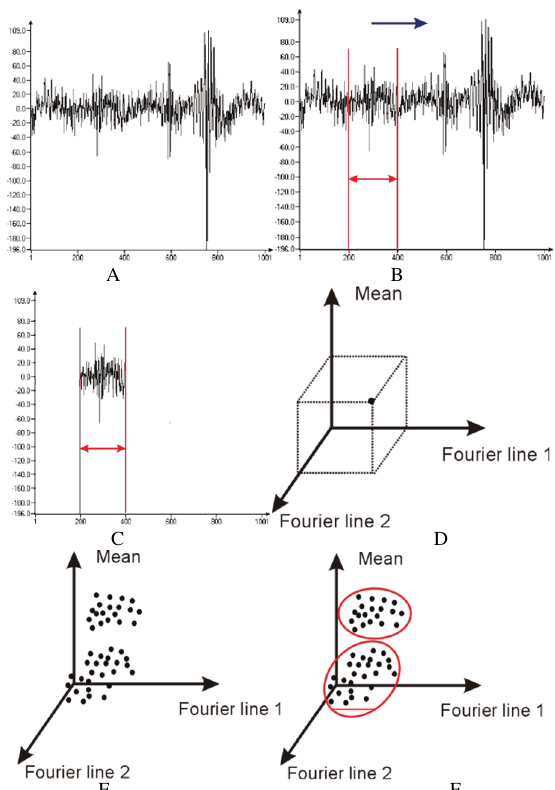
Fig. 2. For the vibration signal (A) the time window is chosen (B) and for the fragment treated as the short-signal (C) the chosen parameters are calculated. The set of parameters values calculated for the given time moment gives the point (vector) in the corresponding parameters space (D). For longer time interval in the parameter space the set of points is observed which represents the time evolution for parameter values (E). Eventually the distribution of points in the parameter space can divide into clusters which can represent different engine states As a time moment usually a sampled time is taken